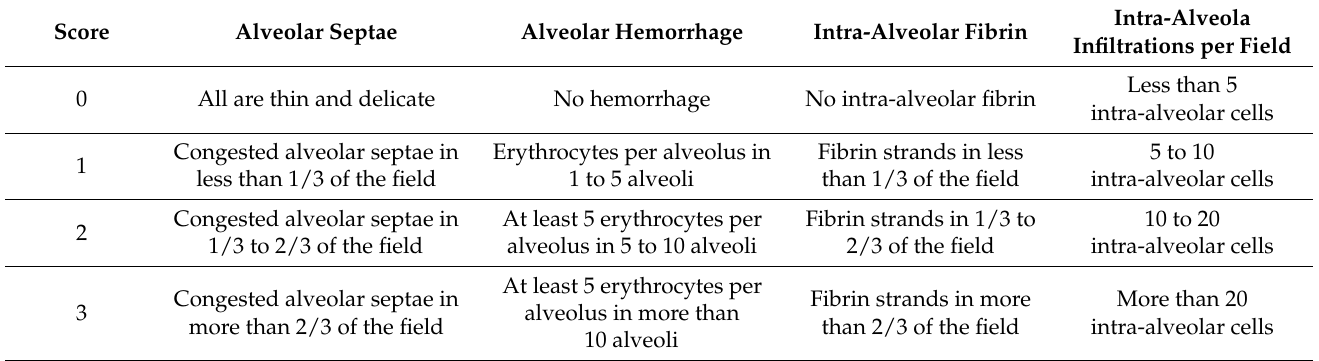
Table 1. Histological